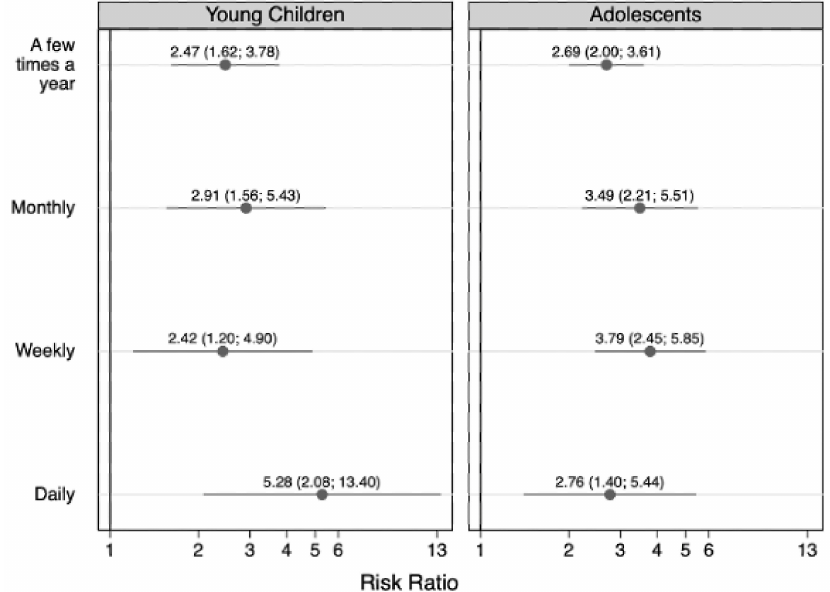
Figure 3. The age-stratified association between having ever resided with someone with a substance use disorder and frequency of children’s depression (young children [5–11 years of age] n = 3135; adolescents [12–17 years of age] n = 3507). Symbols indicate relative risk ratios and lines indicate 95% confidence intervals. The referent group is children who never experienced